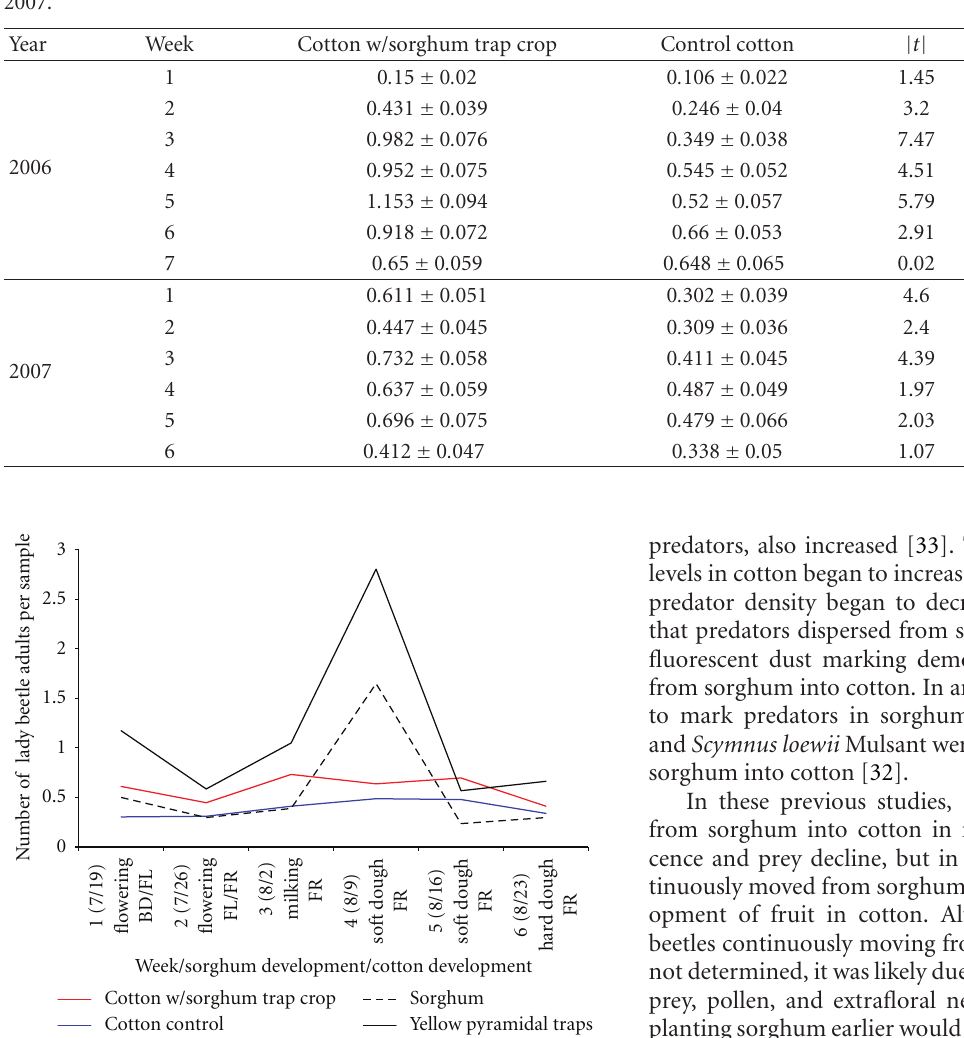
Figure 2: Mean number of lady beetle adults per sample in cotton with a sorghum trap crop, control cotton, sorghum, and yellow pyramidal traps in 2007. BD: buds; FL: flowers; FR: fruit. Number of lady beetles in yellow pyramidal traps divided by 10. Date refers to middle of sampling